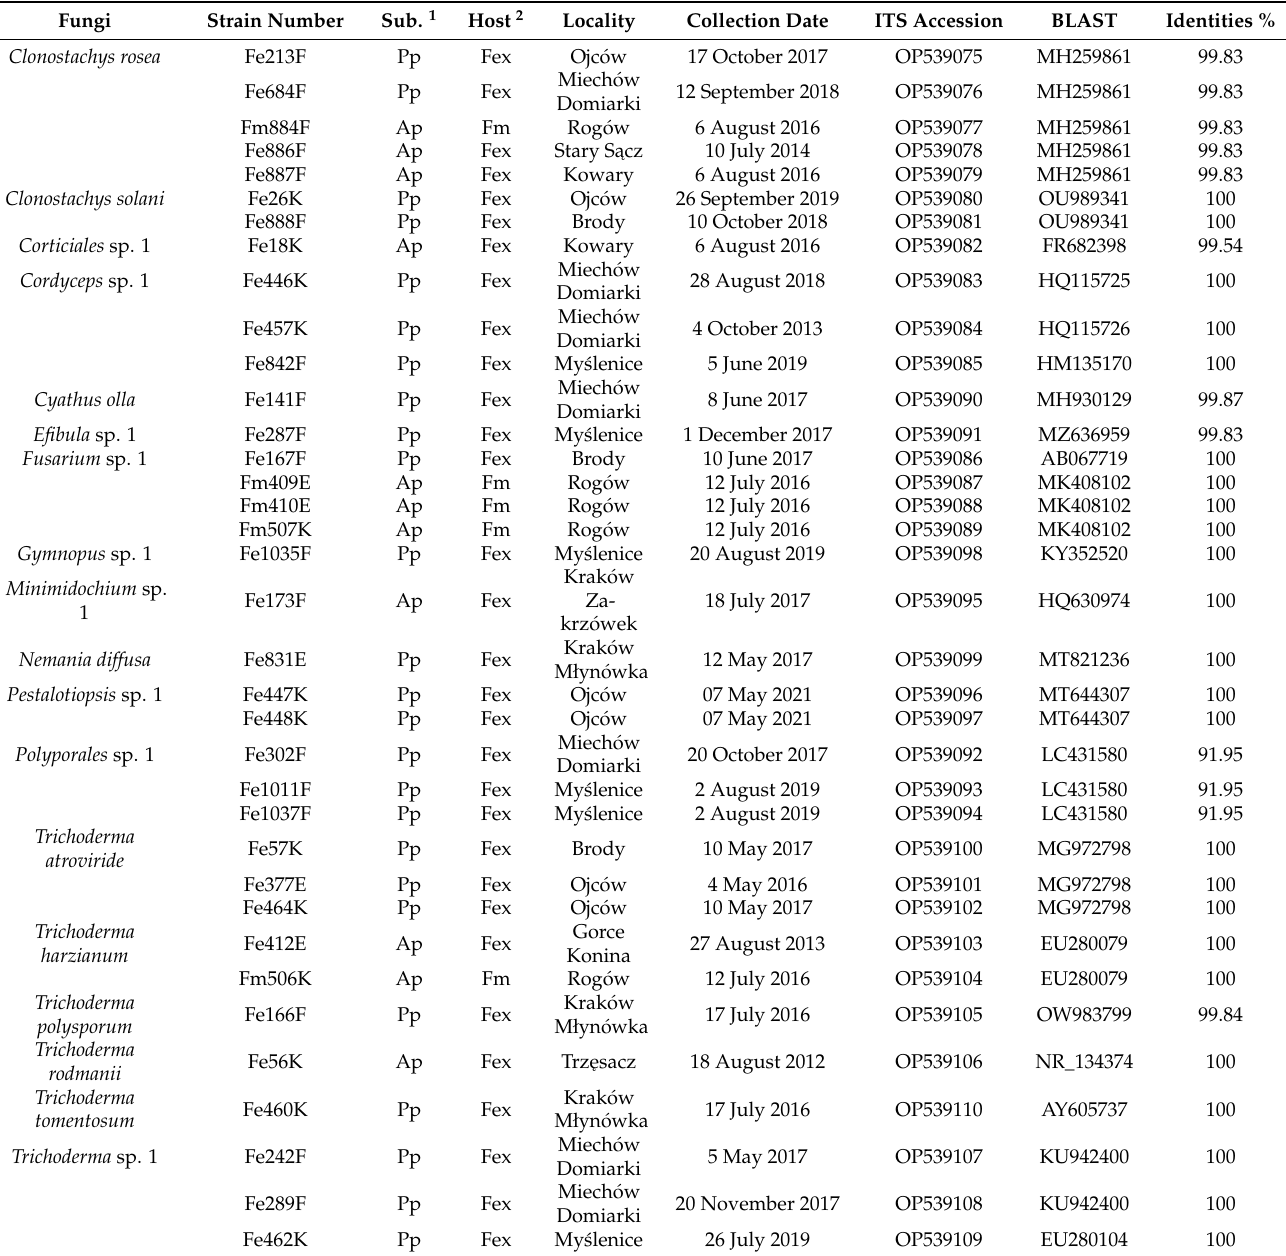
Table 1. Fungi isolated from apothecia and pseudosclerotial plates of Hymenoscyphus fraxineus with symptoms of colonization by other fungi. Sequences were deposited in GenBank. Reference sequences from GenBank were obtained using